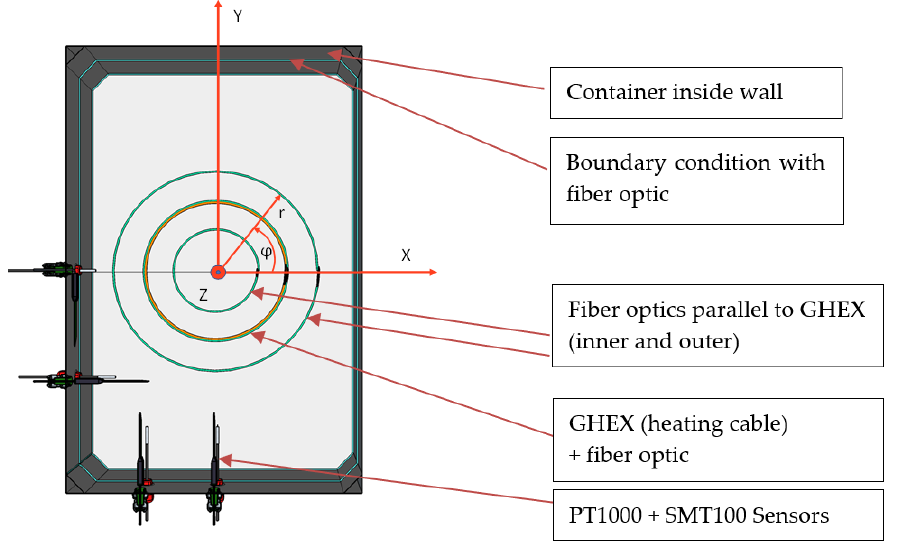
Figure 8. Coordinate system in container—isometric top view.